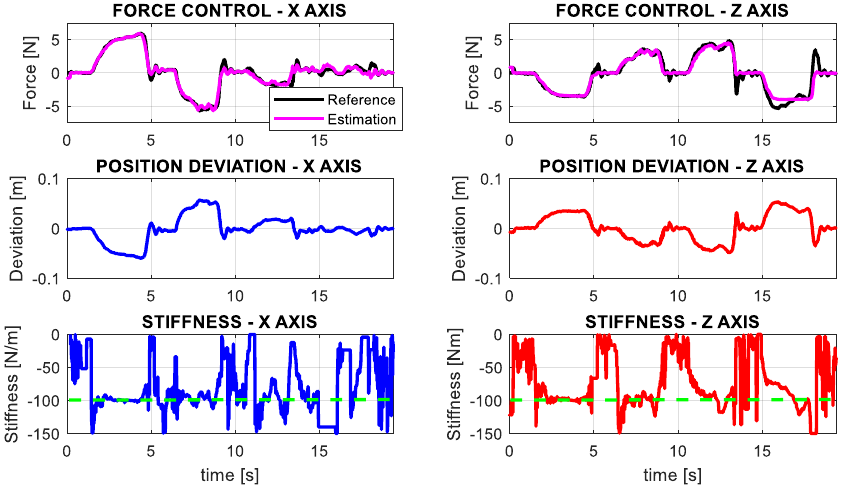
Figure 12 . Force reference estimation (up), position deviation (middle), and instantaneous stiffness (down) in the x - and z -axes for a desired stiffness 𝐾 𝑑 = 100⁡[𝑁𝑚] .